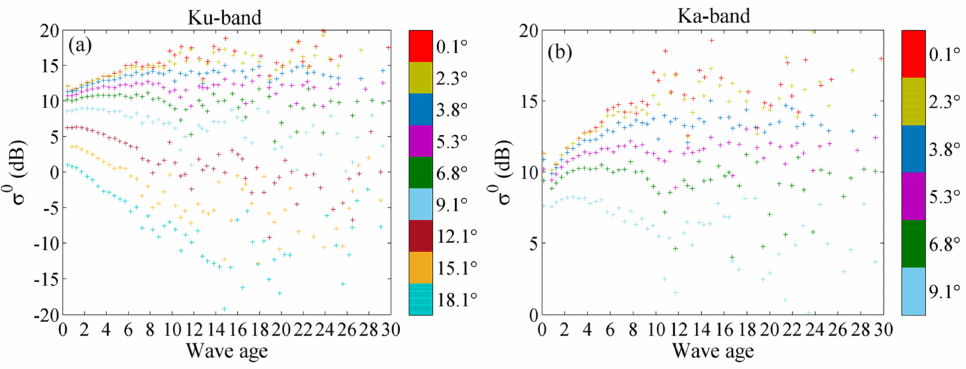
Figure 16. Mean values of binned ( a ) KuPR σ 0 , ( b ) KaPR σ 0 as functions of wave age for selected incidence